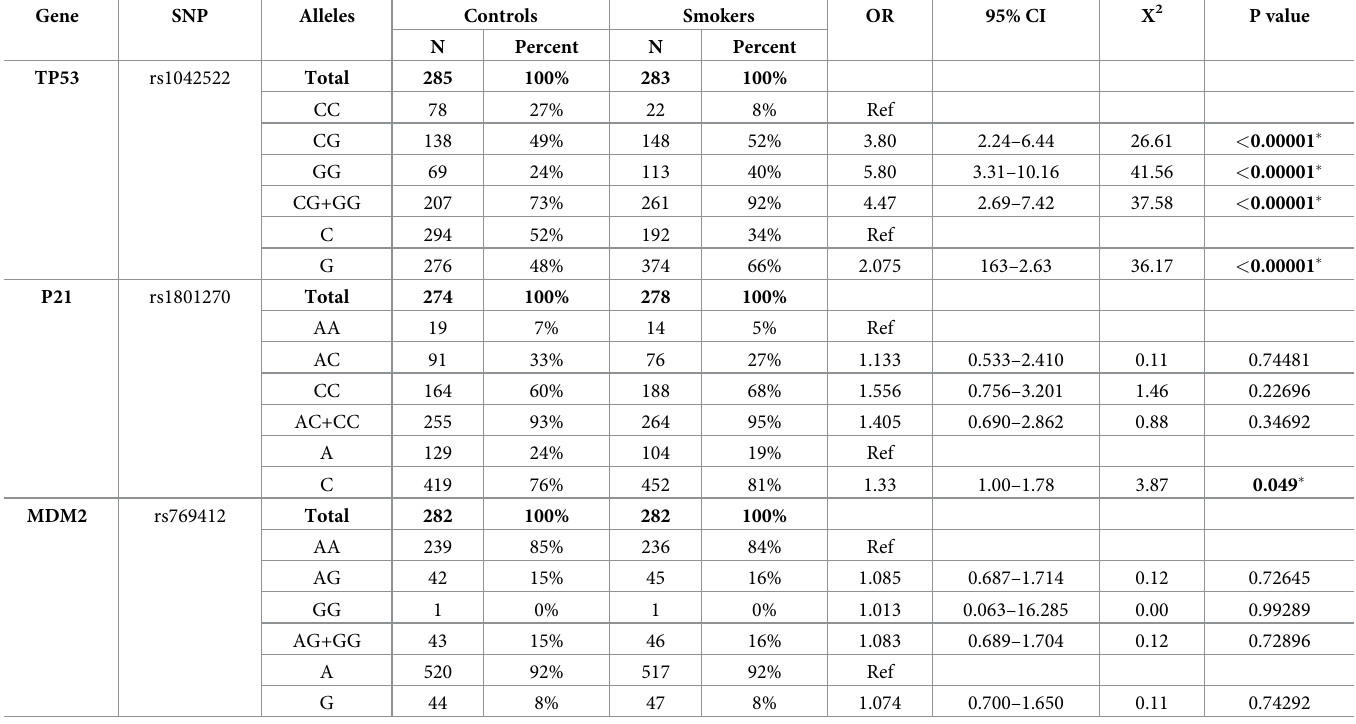
Table 2. General genotype distributions of TP53, P21, and MDM2 gene SNPs among smokers and non-smokers (controls). Gene SNP Alleles